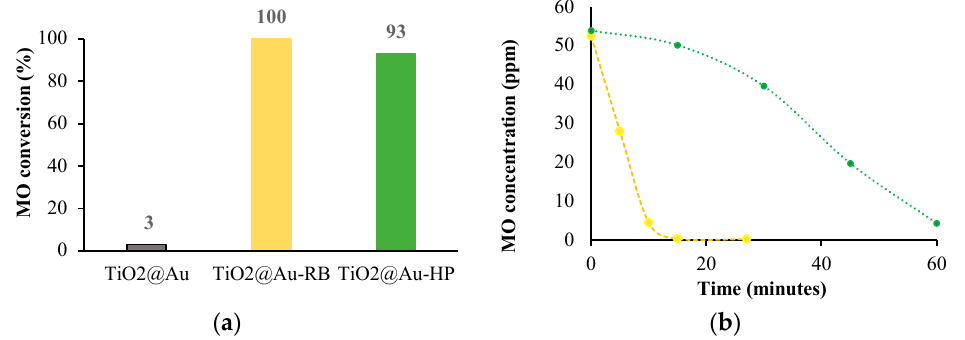
Figure 7. Photocatalytic performances of the gold-doped titania materials prepared by microwave heating for the degradation of methyl orange in near UV ( λ = 365 nm): ( a ) Conversion of methyl orange after 60 min of irradiation ( b ) Evolution of the methyl orange concentration during one hour of irradiation for TiO 2 @Au-RB (yellow) and TiO 2 @Au-HP (green).